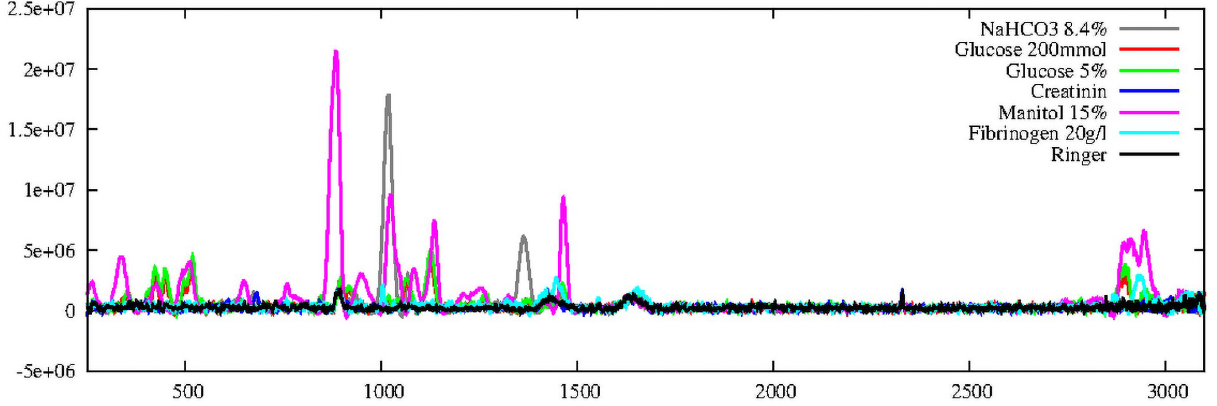
Fig 5. Comparing spectra of individual substances. Shown is the range from 250 to 3100 cm − 1 . For NaHCO 3 and mannitol, creatinine specific peaks are visible, as well as for glucose, fibrinogen, although they are less pronounced. This indicates that not all information is lost in solution. Shown are the background filtered spectra. Exposure 172